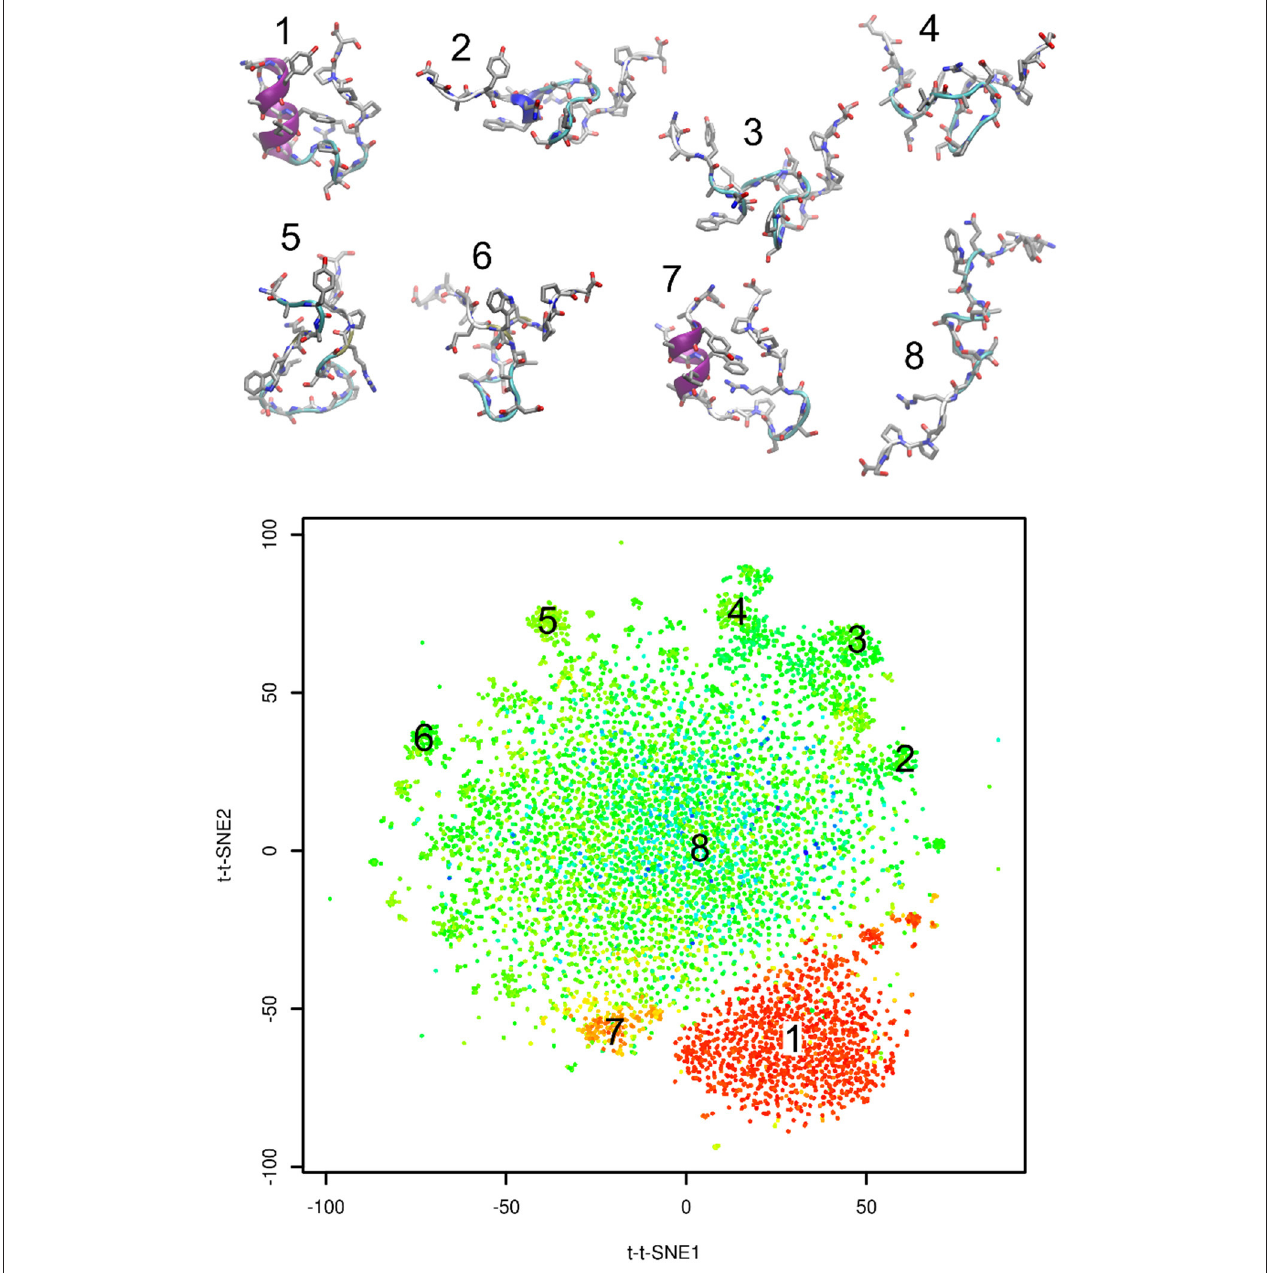
FIGURE 3 | Representative structures projected onto time-lagged t-SNE embeddings. Plot is colored by RMSD from the native structure (as in Figure 2B ).